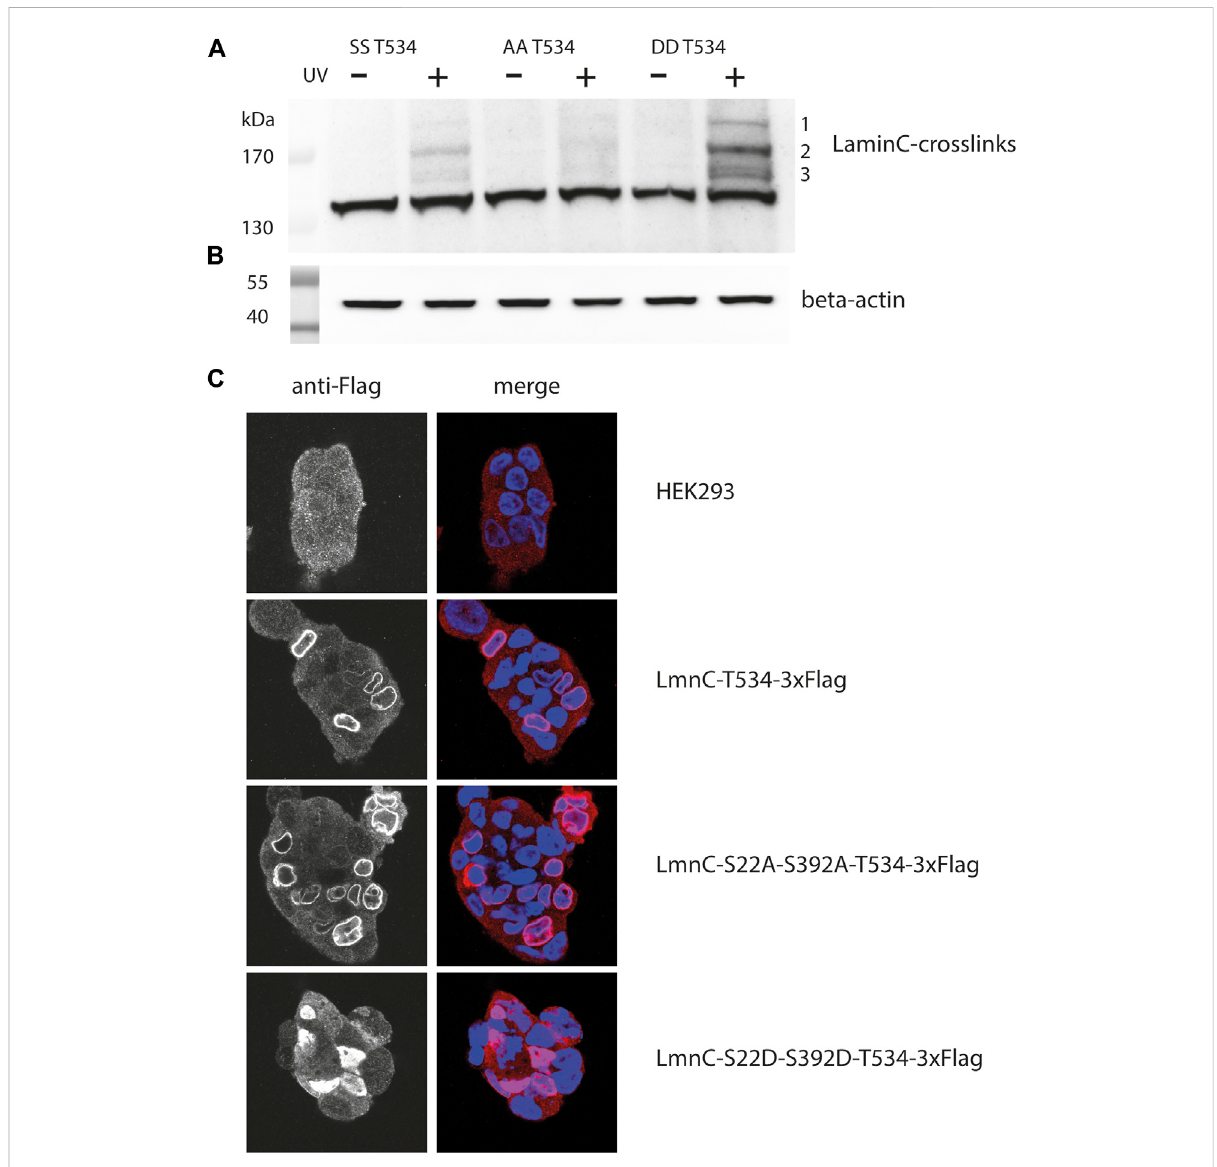
FIGURE 3 Crosslink patterns of laminC-T534pBPA phosphorylation-site mutants. Cells were co-transfected with the amber suppressor plasmid and pLmnC-T534-3x-Flagplasmidscontainingtheindicatedphosphorylation-sitemutations,growninthepresenceofpBPAandexposedtoUV 365nm as indicated. Proteins were analyzed by Western blot and detected with (A) anti-Flag (major crosslinks are numbered with 1 – 3), (B) β -actin antibody (loading control). (C) Localization of the individual cdk1 mutated proteins within the nucleus; blue = DAPI stain, red = Cy3 anti-Flag